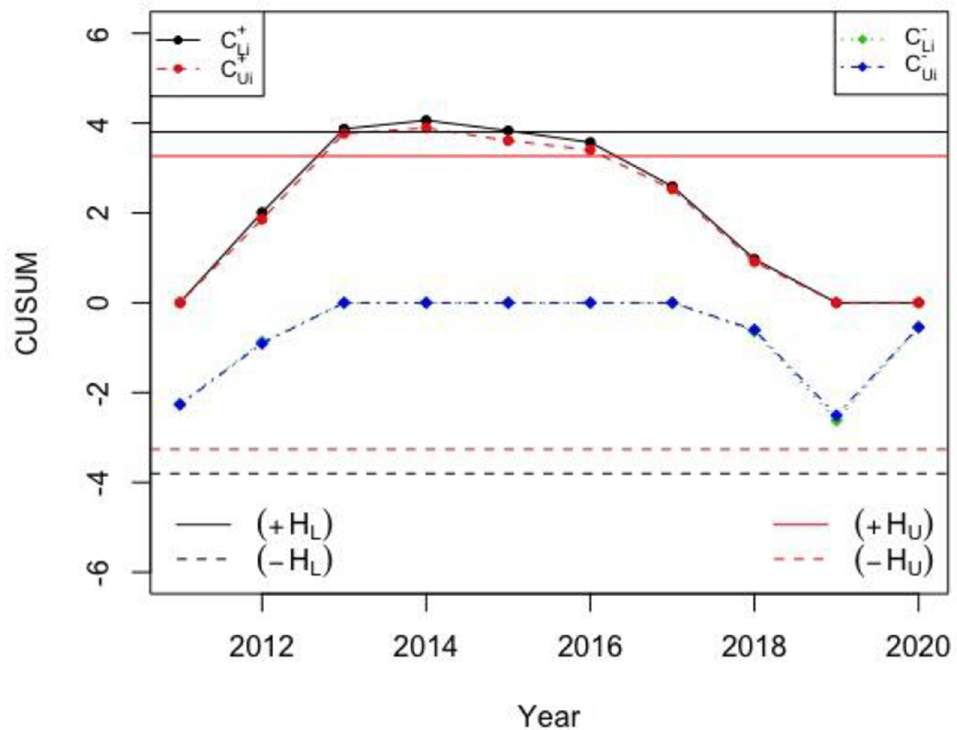
Fig 3. Real-life data from PSO petroleum oil company’s stock price for the proposed NCUSUM � X chart with H N 2 [3.265, 3.803] and K N 2 [0.3397, 0.3958].